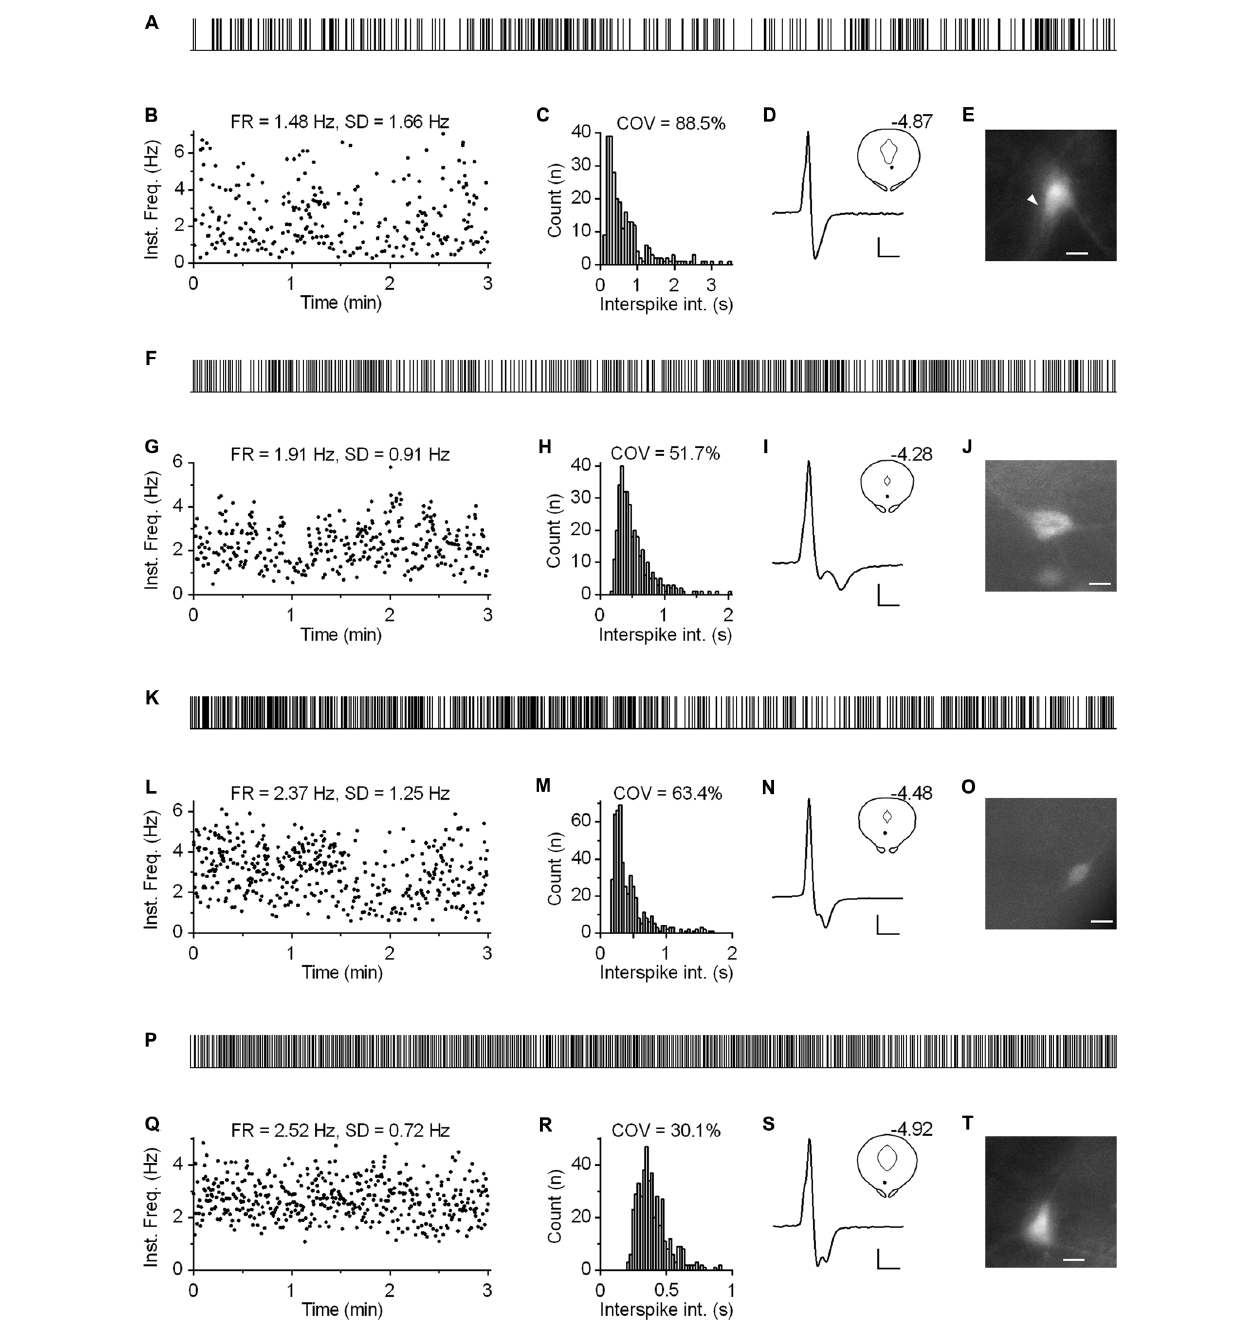
FIGURE 8 | Subset of serotonergic neurons exhibits somewhat irregular spiking. (A) 3-min-long spike train of an irregularly spiking serotonergic neuron. TSC mouse, PE-induced firing. (B) Time-course of instantaneous frequency of spike train shown in (A) . FR stands for the firing rate. SD stands for standard deviation of instantaneous frequency. (C) ISI histogram of the train shown in (A) . COV denotes variation coefficient of ISI. (D) Average spike of the same recording. Scale bars: 8 pA, 1 ms. Inset shows anatomical location of the neuron. Number indicates distance from bregma. (E) Fluorescence image of the recorded neuron. Scale bar: 10 µ m. (F–J) Irregularly spiking serotonergic neuron in PRY mouse. NA-induced firing. (F) 3-min-long spike train. (I) Scale bars: 15 pA, 1 ms. Inset shows the anatomical location of the neuron. The number indicates distance from bregma. (J) Fluorescence image of the recorded neuron. Scale bar: 10 µ m. (K–O) Irregularly spiking serotonergic neuron in PRY mouse. PE-induced firing. (K) 3-min-long spike train. (N) Scale bars: 15 pA, 1 ms. Inset shows anatomical location of the neuron. (O) Fluorescence image of the recorded neuron. Scale bar: 10 µ m. (P–T) Moderately regularly spiking serotonergic neuron in PRY mouse. PE-induced firing. (P) 3-min-long spike train. (S) Scale bars: 15 pA, 1 ms. Inset shows the anatomical location of the neuron. The number indicates distance from bregma. (T) Fluorescence image of the recorded neuron. Scale bar: 10 µ m.